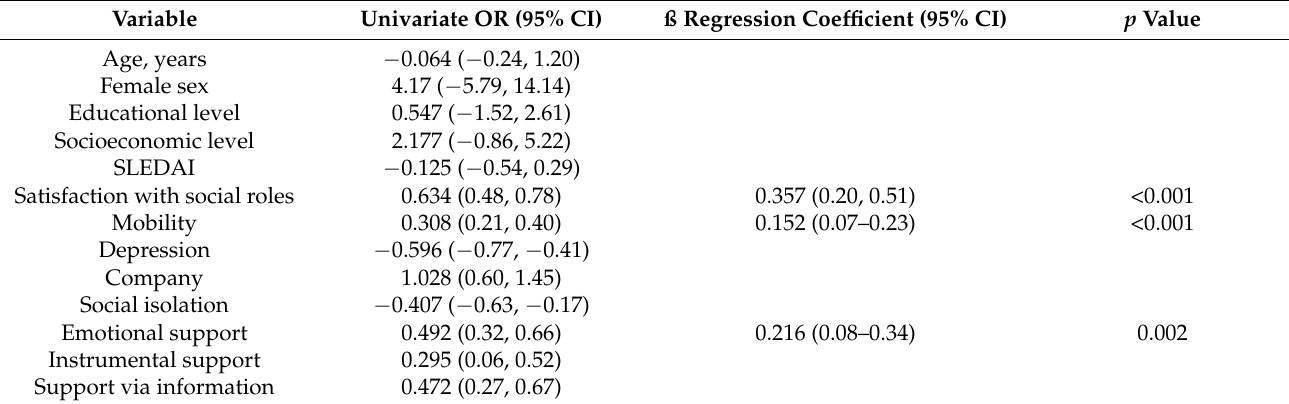
Table 6. Multivariable linear regression analysis of the characteristics associated with ability to participate in social activities in patients with